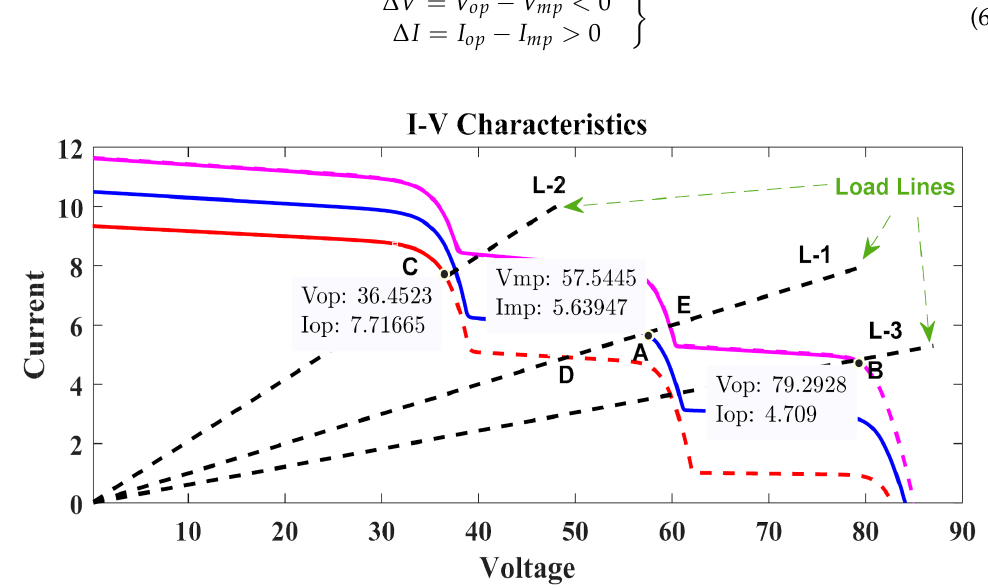
Figure 4. I–V characteristics under combined variation of load and